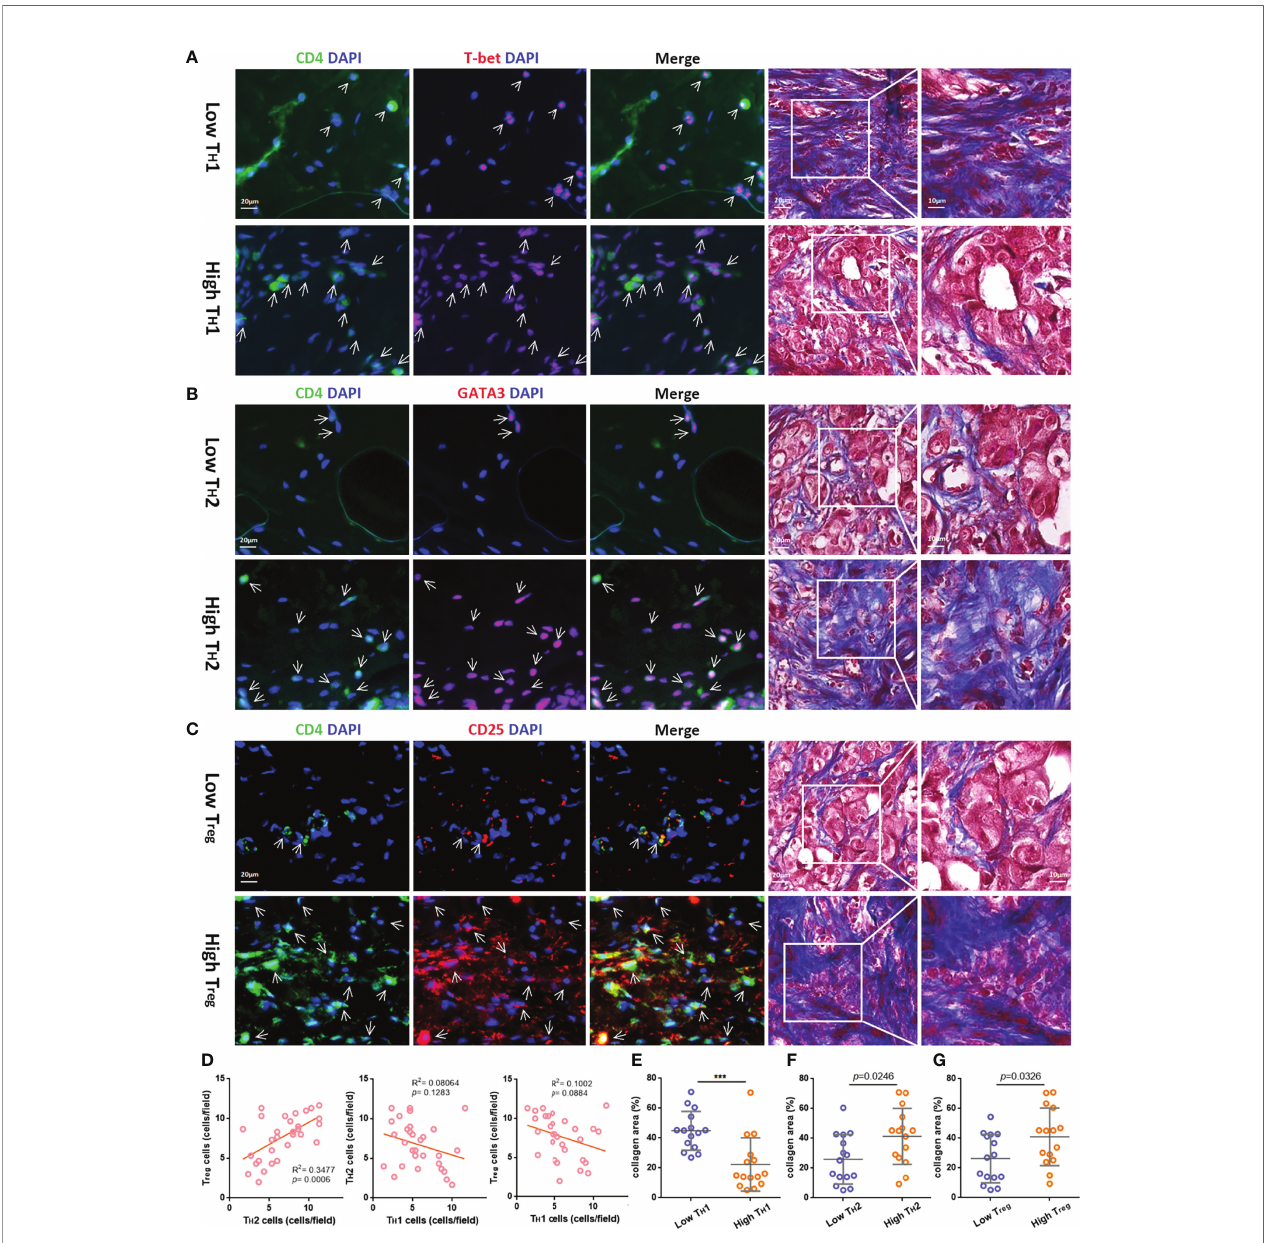
FIGURE 4 | The relativity between different T H cell subtypes and the correlation of different T H cell subtypes and ECM in the TIME. Representative immuno fl uorescent staining for CD4 (green), T-bet, GATA3, or CD25 (red) and 4,6-diamidino-2-phenylindole (DAPI) (blue) (bar = 20 m m.) and corresponding Masson ’ s trichrome staining (bar = 10/20 m m.) in TNBC samples with low or high tumor-in fi ltrating T H 1 (A), T H 2 (B) , and T reg cells (C) , which are indicated by arrows. (D) Pearson correlation analysis of the three subtypes of T H cells. The t -test analysis of variance between the collagen area of two groups with low or high tumor-in fi ltrating T H 1 (E) , T H 2 (F) , and T reg cells (G) . *** p value <